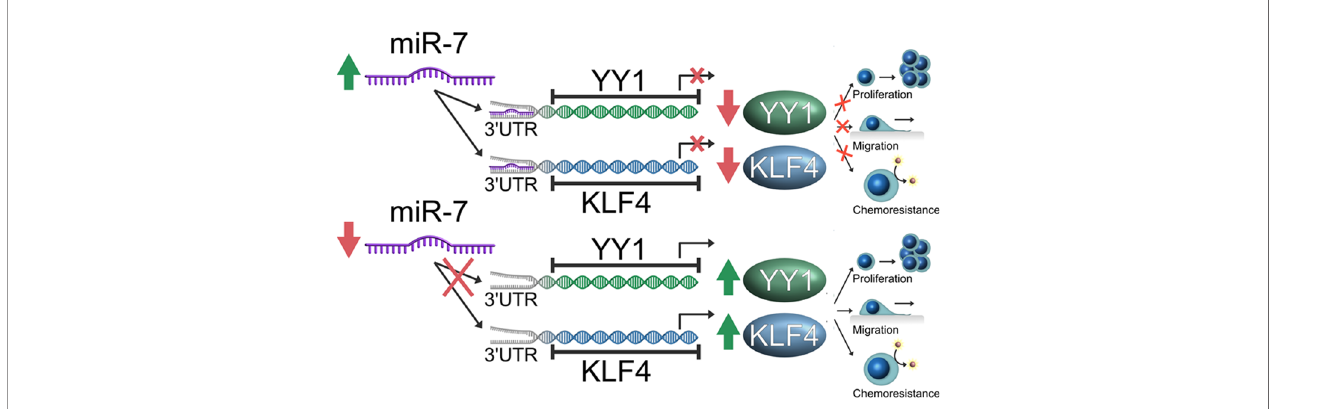
FIGURE 7 | Schematic representation of the model of the role of miR-7 in the YY1/KLF4 axis regulation, and the implication of this axis in migration and chemoresistance of non-Hodgkin lymphoma (NHL). Our model proposes that miR-7 plays a role as tumor inhibitor in Lymphoma, where a low expression of miR-7 allows the high expression of YY1/KLF4 with the fi nal result of the increase in proliferation, migration and chemoresistance, while high miR-7 expression inhibits YY1/ KLF4 expression by attenuating proliferation and migration and reversing chemoresistance in